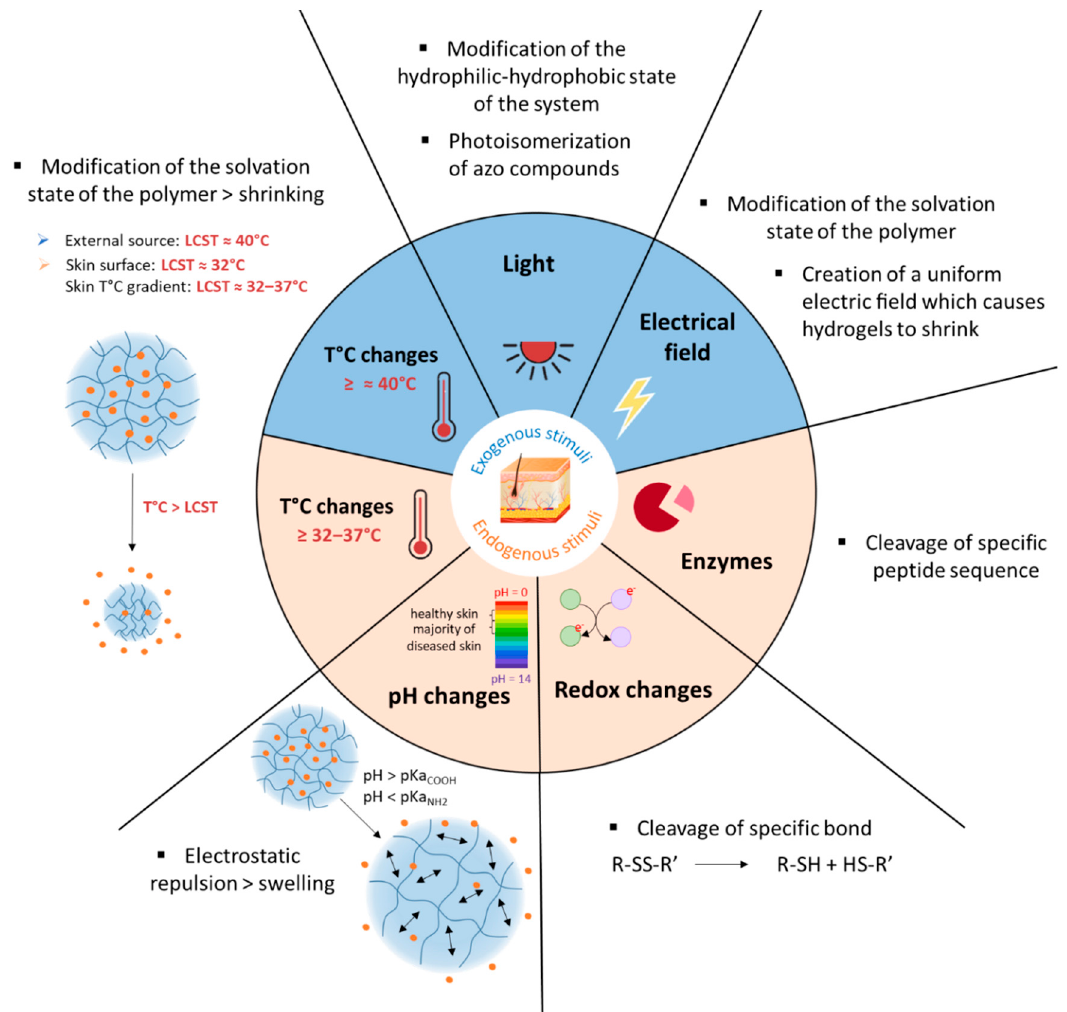
Figure 2. Schematic overview of stimuli and their mode of action, applied to the design of smart drug delivery systems for skin applications.